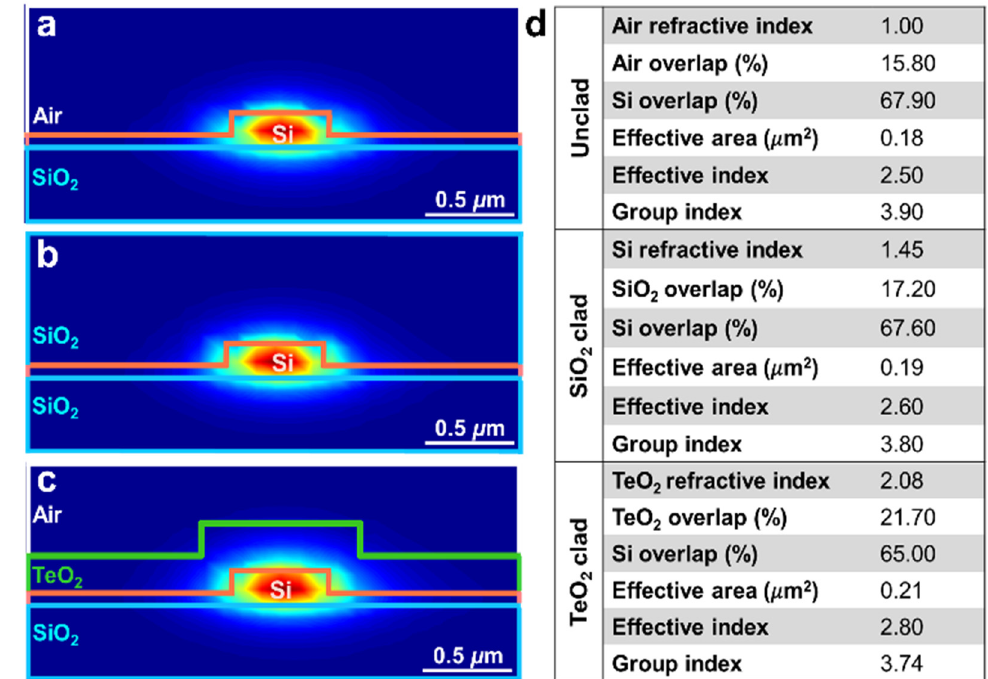
Figure 2. Calculated electric field profile of the fundamental transverse-electric (TE)-polarized mode for ( a ) unclad, ( b ) SiO 2 -clad, and ( c ) TeO 2 -clad silicon microring resonators. ( d ) Calculated fractional optical intensity overlap factors and effective mode areas for the fundamental TE microring mode at 1550 nm wavelength.